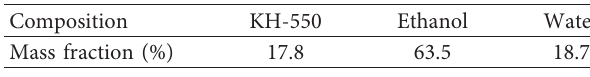
Figure 4: GPC analysis diagram of asphalt.